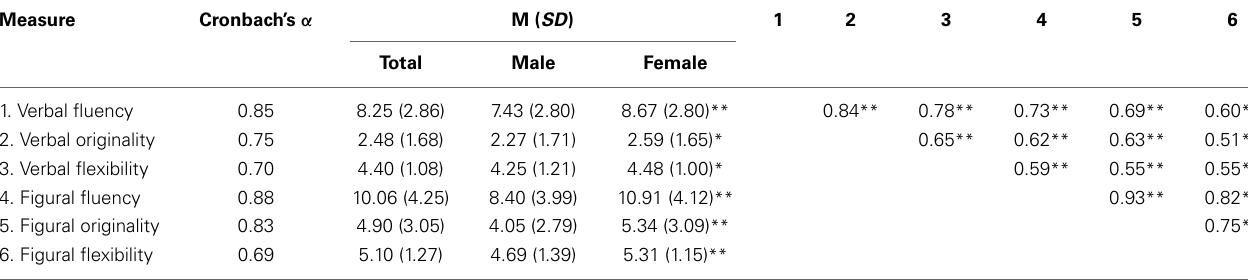
Table 1 | Descriptive statistics and inter-correlations a . Measure